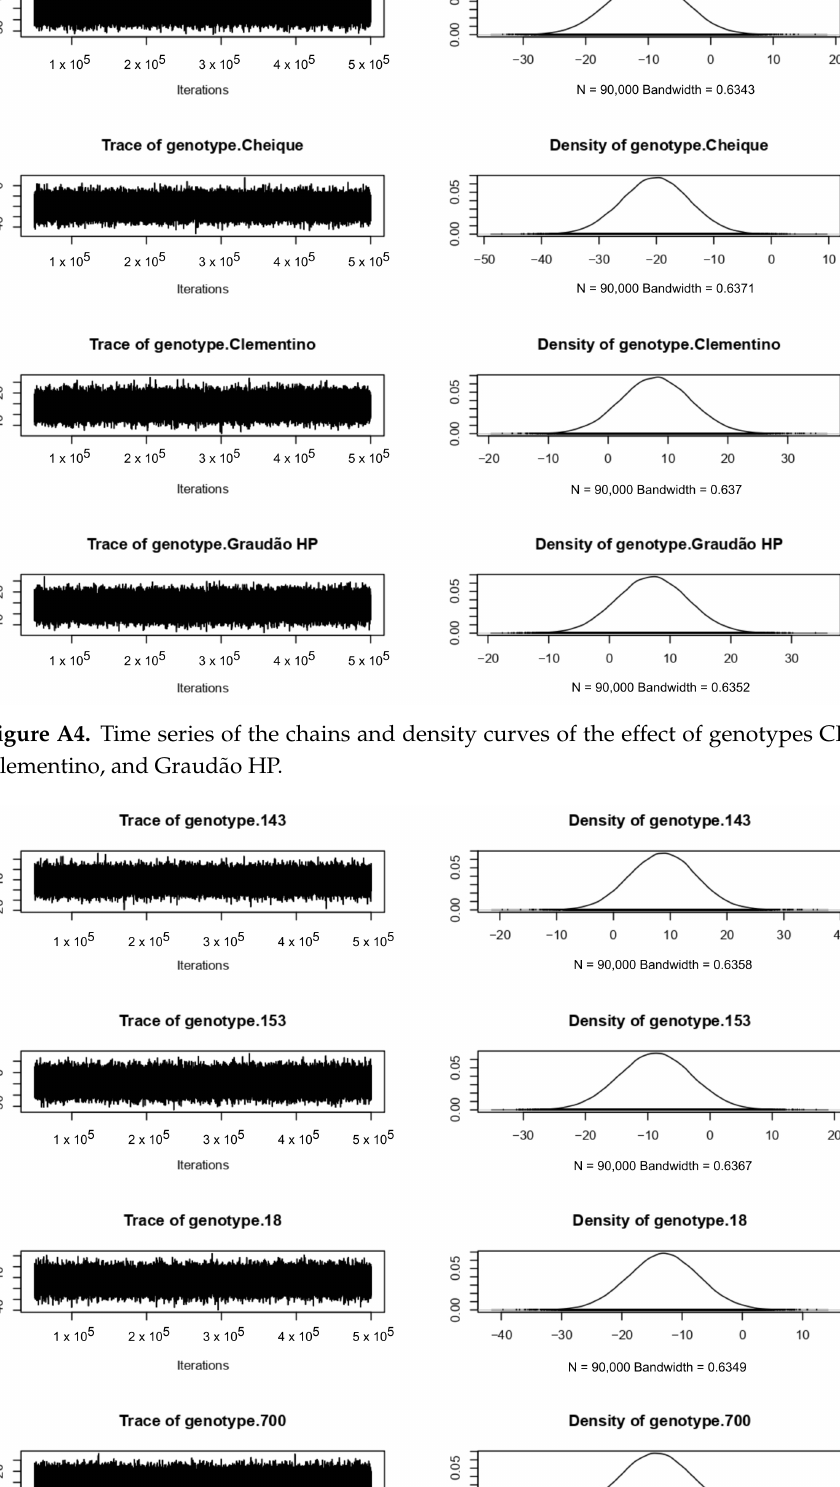
Figure A6. Distribution of residuals for each fitted value. References 1.